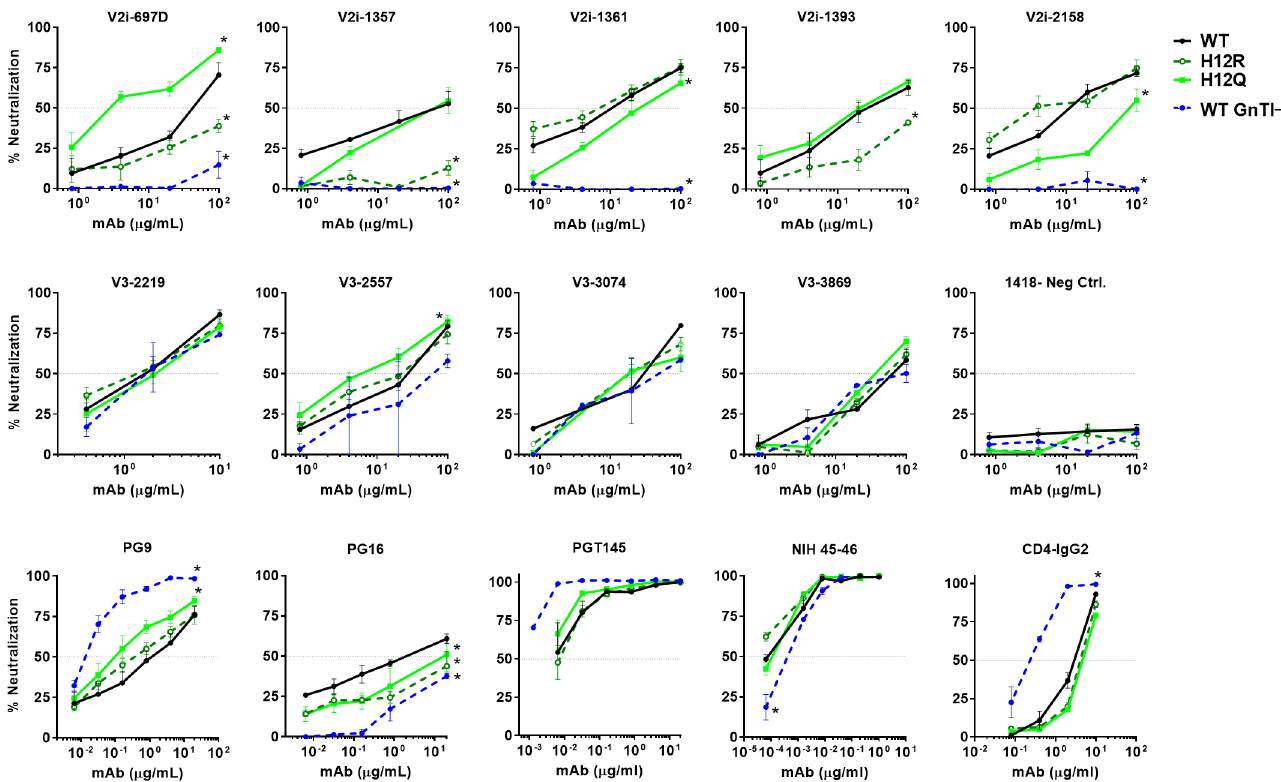
Fig 2. Neutralization of REJO WT and mutant viruses by different MAbs and CD4-IgG2. Virus neutralization was measured using the TZM.bl target cells after the viruses were incubated with serially diluted MAbs at 37˚C for 24 hours prior to addition of the target cells, except for PG9, PGT145, NIH45-46, and CD4-IgG2 which were pre-incubated with viruses for 1 hour. The irrelevant control MAb 1418 was included for negative control. Means and standard errors from two to three independent experiments are shown. (cid:3) , p < 0.05 from the two-way ANOVA as compared to neutralization of the WT virus. Data from two SP mutants (H12R and H12Q) are shown. Neutralization data of WT REJO produced in 293S GnTI - cells (WT GnTI - ) are also presented for comparison.